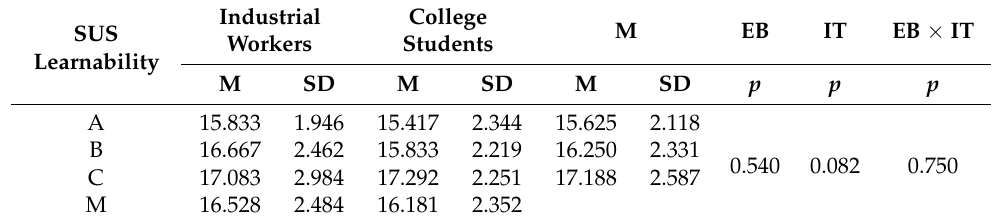
Table 3. Descriptive statistics and two-way ANOVA of SUS